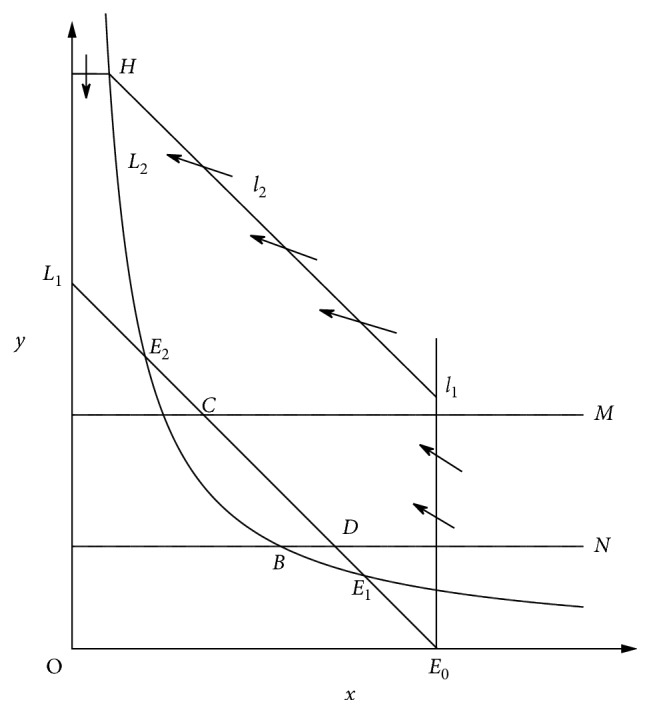
System (3) is the uniformly bounded.